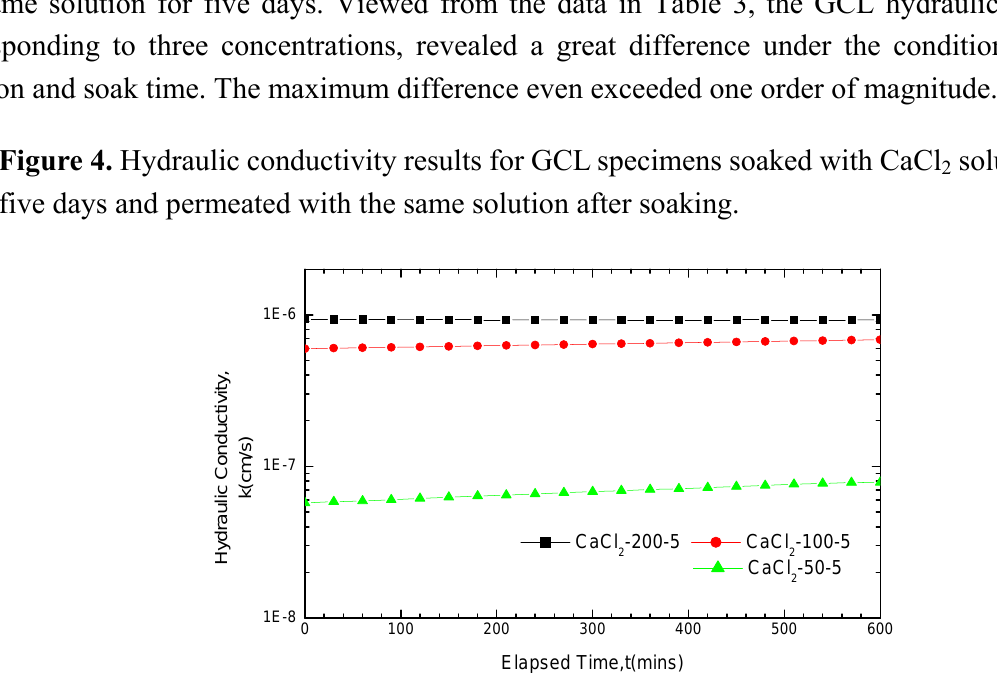
Figure 5. Hydraulic conductivity results for GCL specimens soaked with NaCl solution for five days and permeated with the same solution after